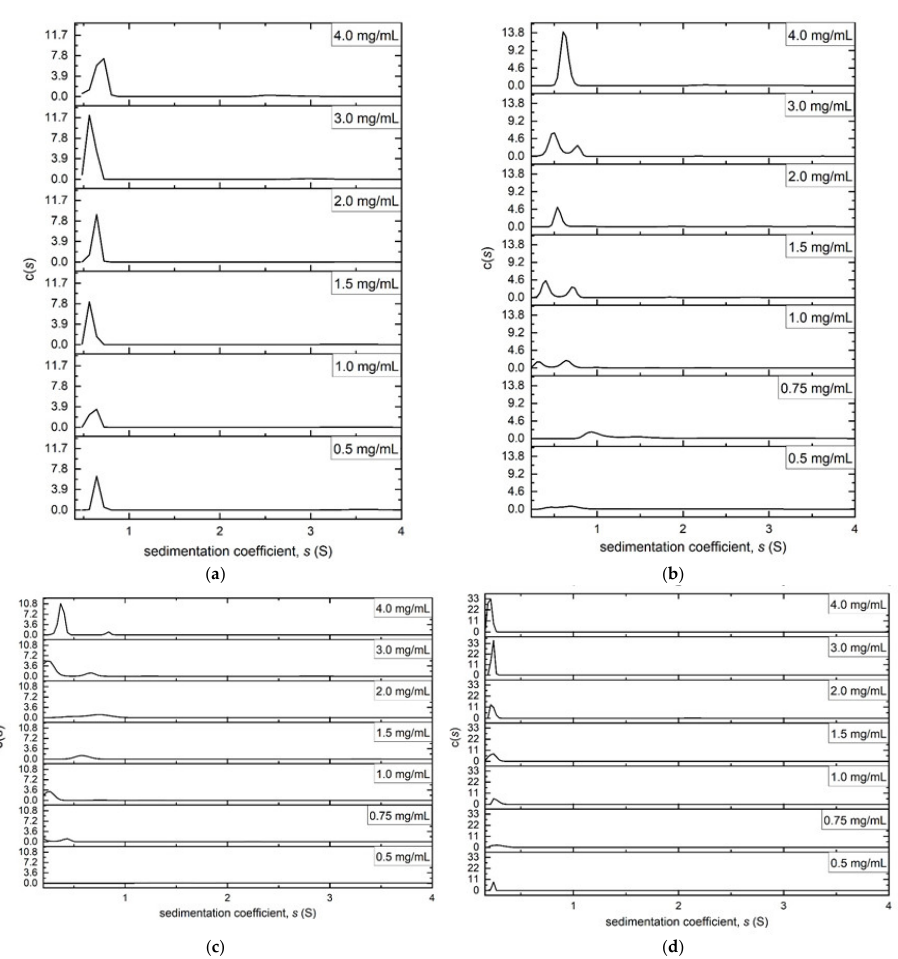
Figure 6. Sedimentation coefficient distributions of the PDMS-OH series at different loading concentrations in isopropanol. Rotor speed = 49,000 rpm, temperature = 20.0 °C ( a ) PS36000, ( b ) PS18000, ( c ) PS4200, ( d ) PS550.